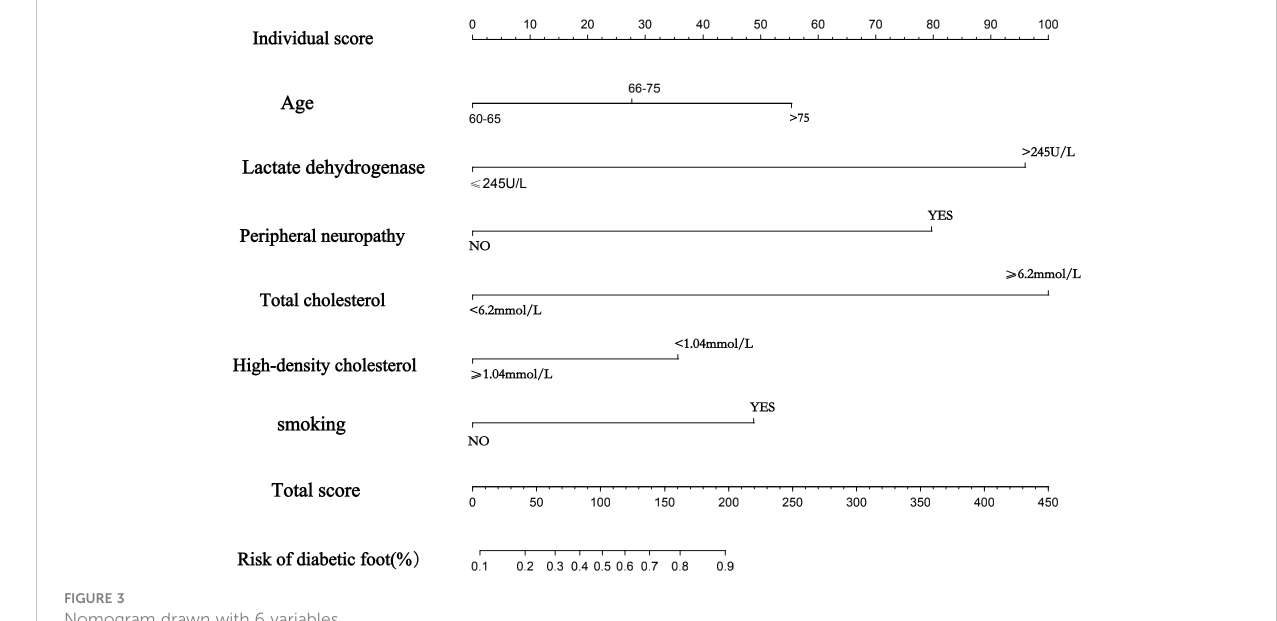
FIGURE 3 Nomogram drawn with 6 variables.